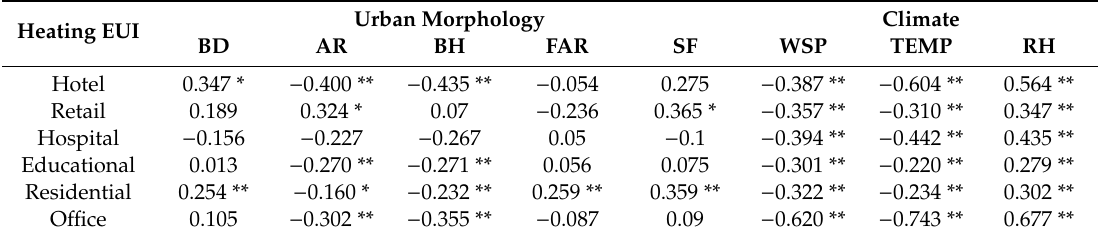
Table 3. Pearson correlations of heating EUI and urban environmental